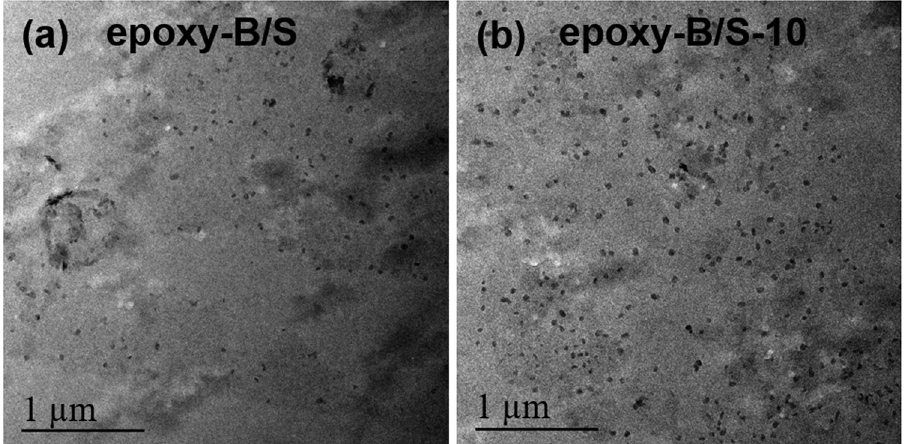
Figure 9: TEM observation of unmodi fi ed and GMA - modi fi ed B/S particles dispersed in the cured epoxy resin. ( a ) epoxy - B/S and ( b ) epoxy - B/S - 10.